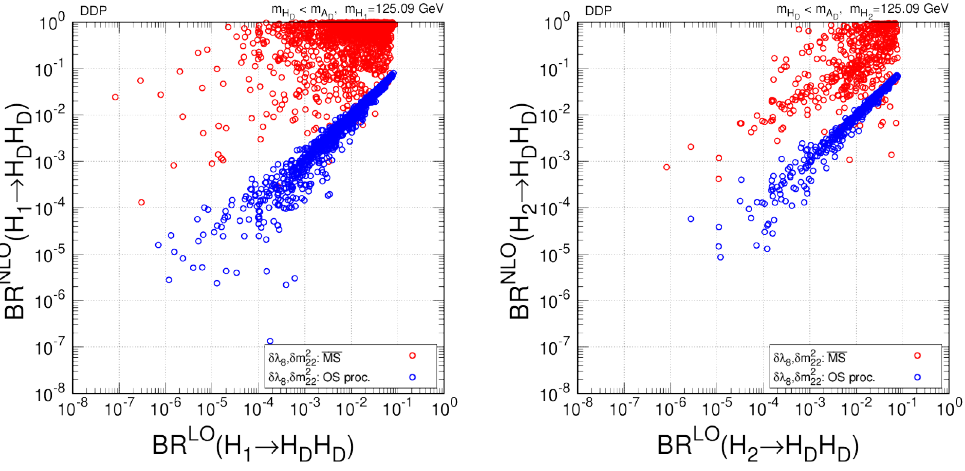
Figure 3 . Projections of the allowed parameter space in the planes ( λ 8 , m 2 (sin α, m ) (right), where m is the mass of the non-SM-like Higgs boson. The red points are other other for scenario 1 and the blue points are for scenario 2.